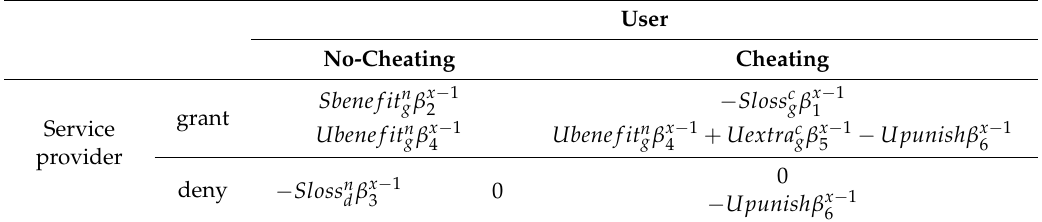
Table 3. Payment matrix between user and service provider with user